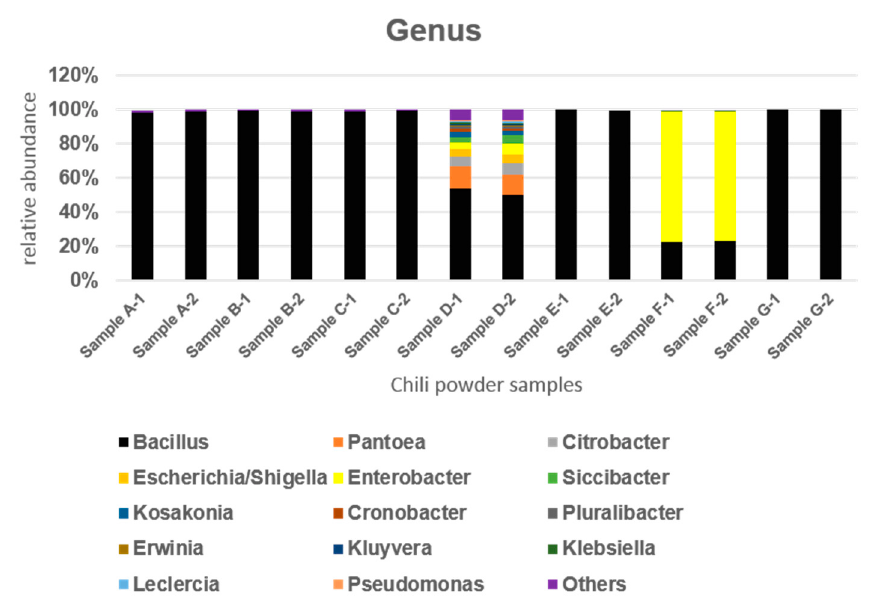
Figure 1. Taxonomic composition in seven commercial chili powder samples. The bar graph represents the relative abundance in percentage and depicts the average community composition of bacteria in the samples. The 16S rRNA genes were amplified and sequenced in duplicate as described in Materials and Methods.